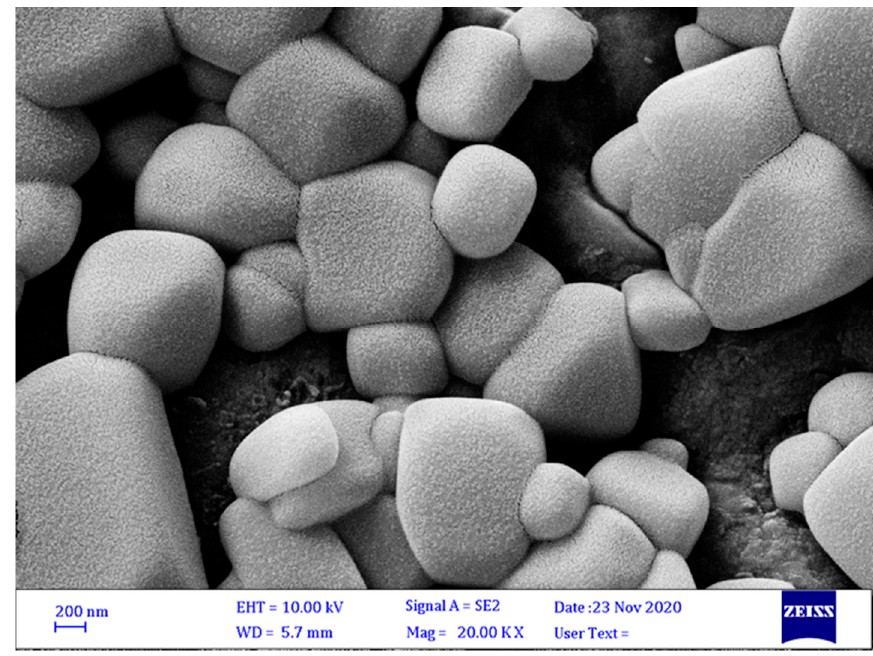
Figure 2. Morphology of microcapsules under the scanning electron microscope .